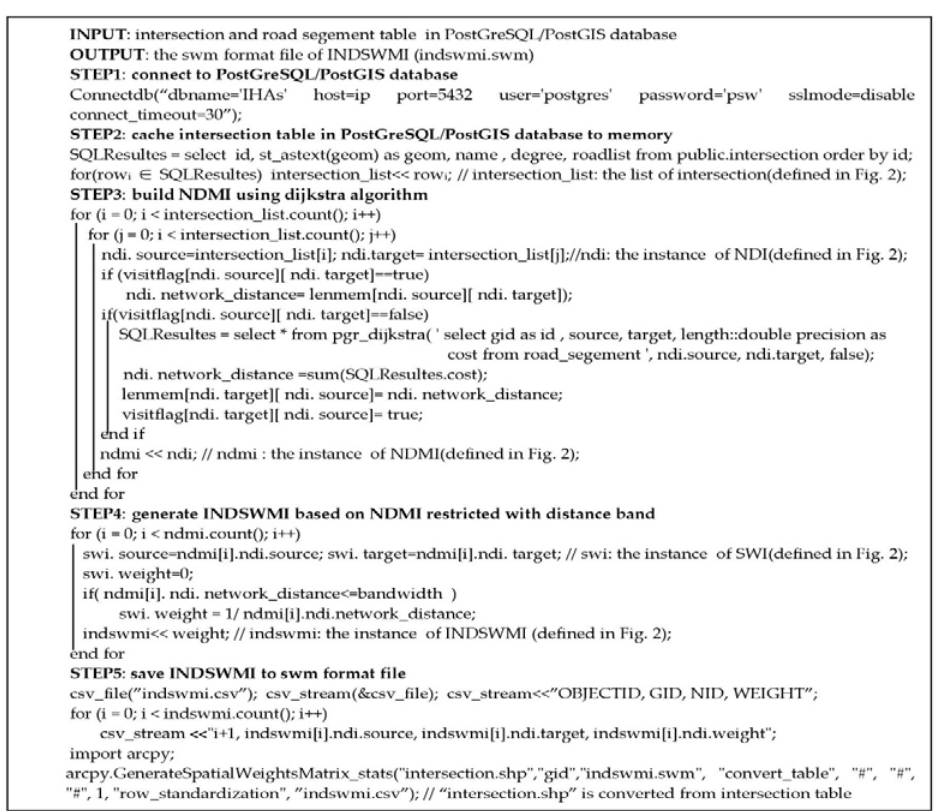
Figure 3. The INDSWMI generation algorithm.